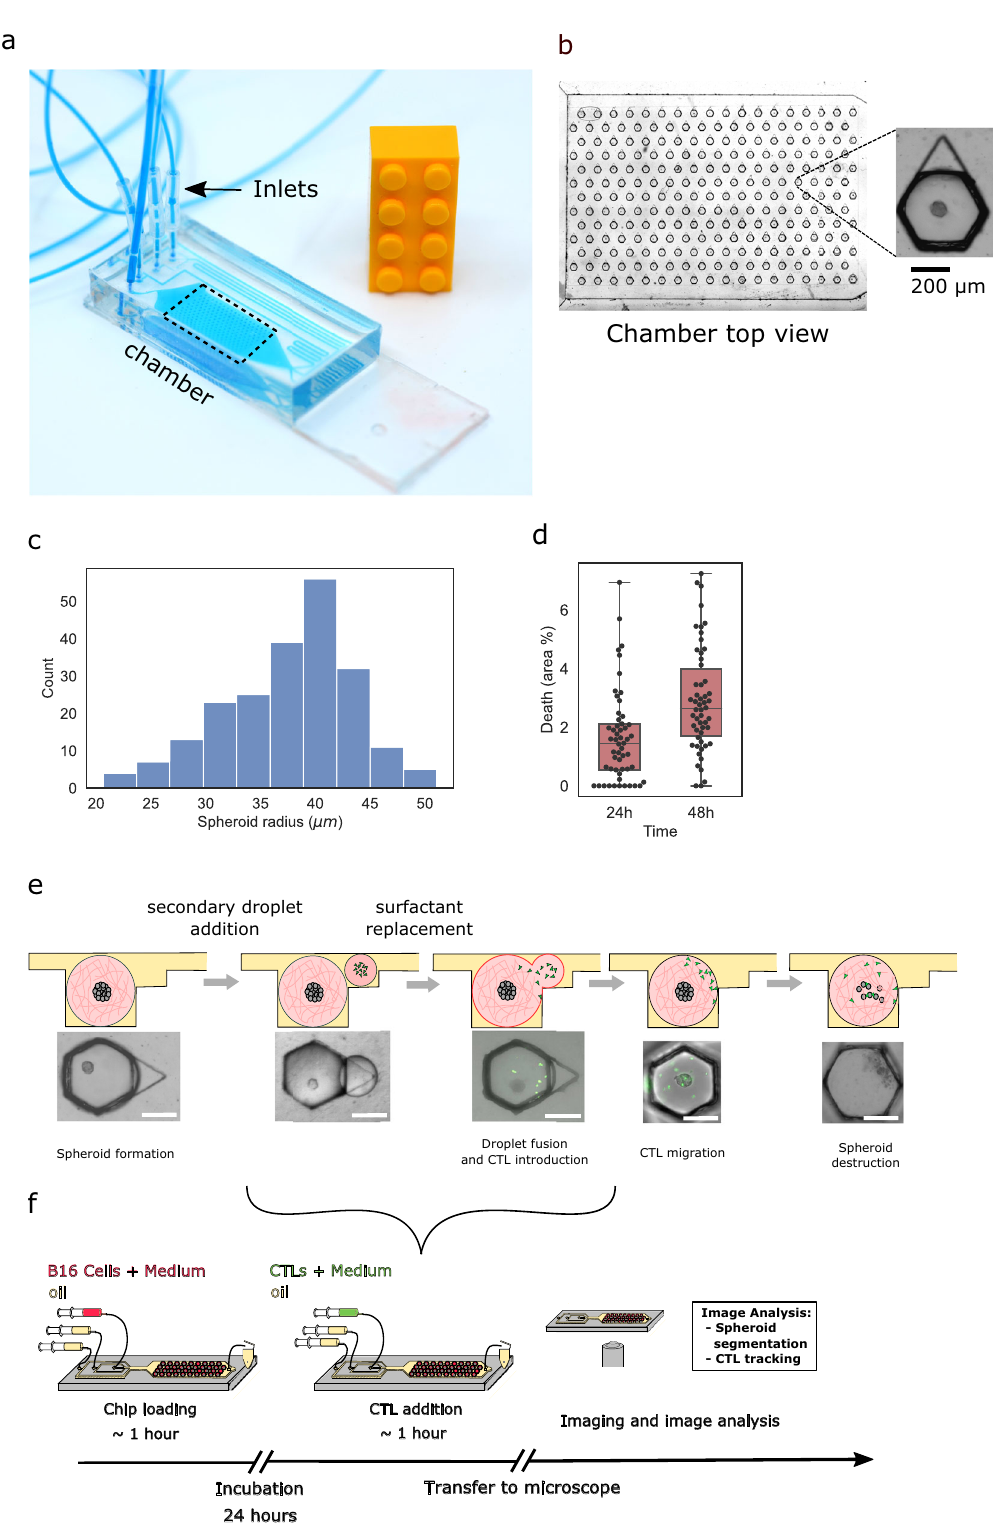
Fig. 1 Micro fl uidic immuno-oncology chip and protocol. a Micro fl uidic chip on a standard glass slide. b Expanded view of the trapping region of the chip (dashed box) showing an array of 234 trapped droplets. Each droplet contains a single B16 spheroid in Matrigel, as shown in the inset. c Distribution of spheroid radii within a single chip ( N = 215). d Viability measurements using live-dead staining after 24 and 48 h ( N = 54). e Schematic showing a primary droplet with a tumor spheroid, followed by the addition and fusion of a secondary droplet containing GFP-labeled CTLs, eventually leading to tumor cell killing and spheroid fragmentation. Scale bar is 200 μ m. f Schematic representation of the complete experimental